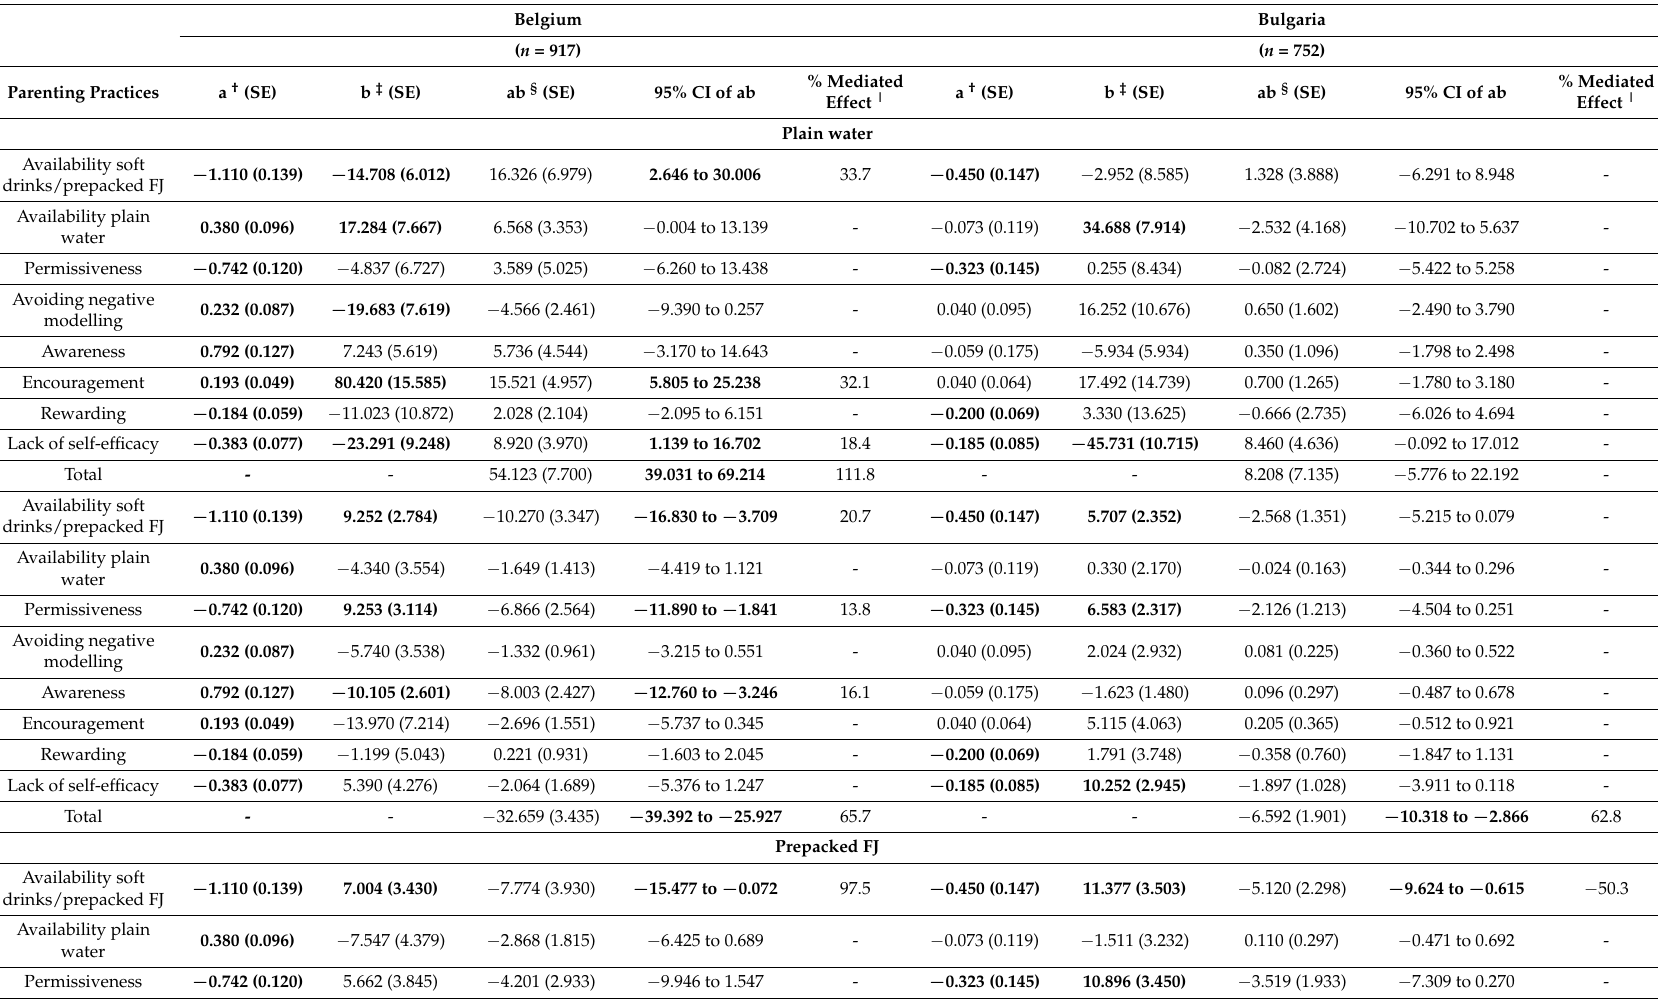
Table 4. Results from the multilevel multiple regression analyses (three level random intercept model) with plain water, soft drinks and prepacked fruit juice as the outcome variables. All analyses were adjusted for preschoolers’ age and gender (country-specific